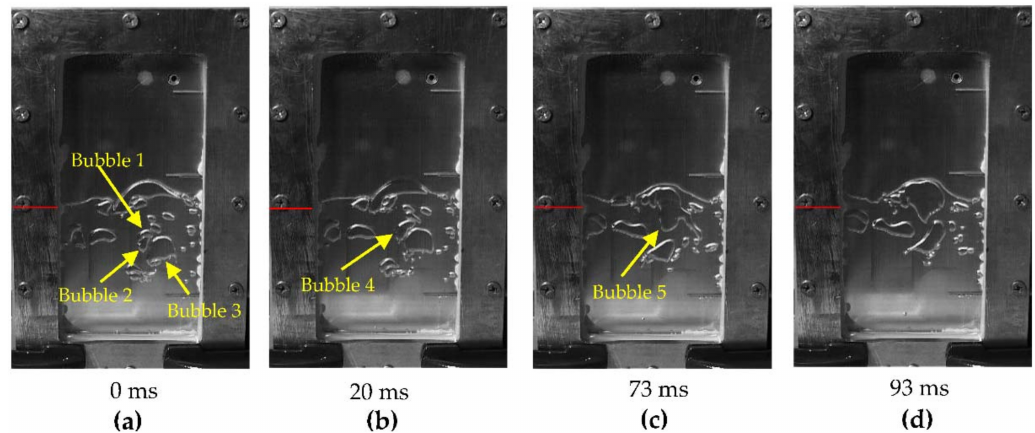
Figure 18. Time-series diagram of the merging of bubbles in the cavity of the PGHP (FR = 48%, Q in = 100 W). Note: the initial level is shown as the red line, ( a ) bubble behavior at 0 ms; ( b ) 20 ms; ( c ) 73 ms; ( d ) 93 ms.